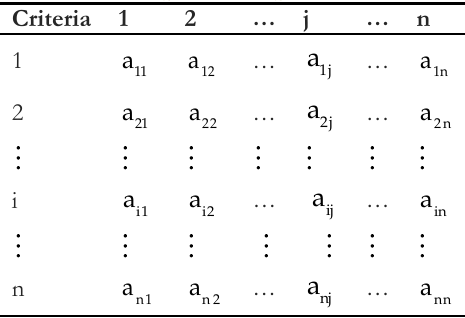
Table 3. Comparison of paired